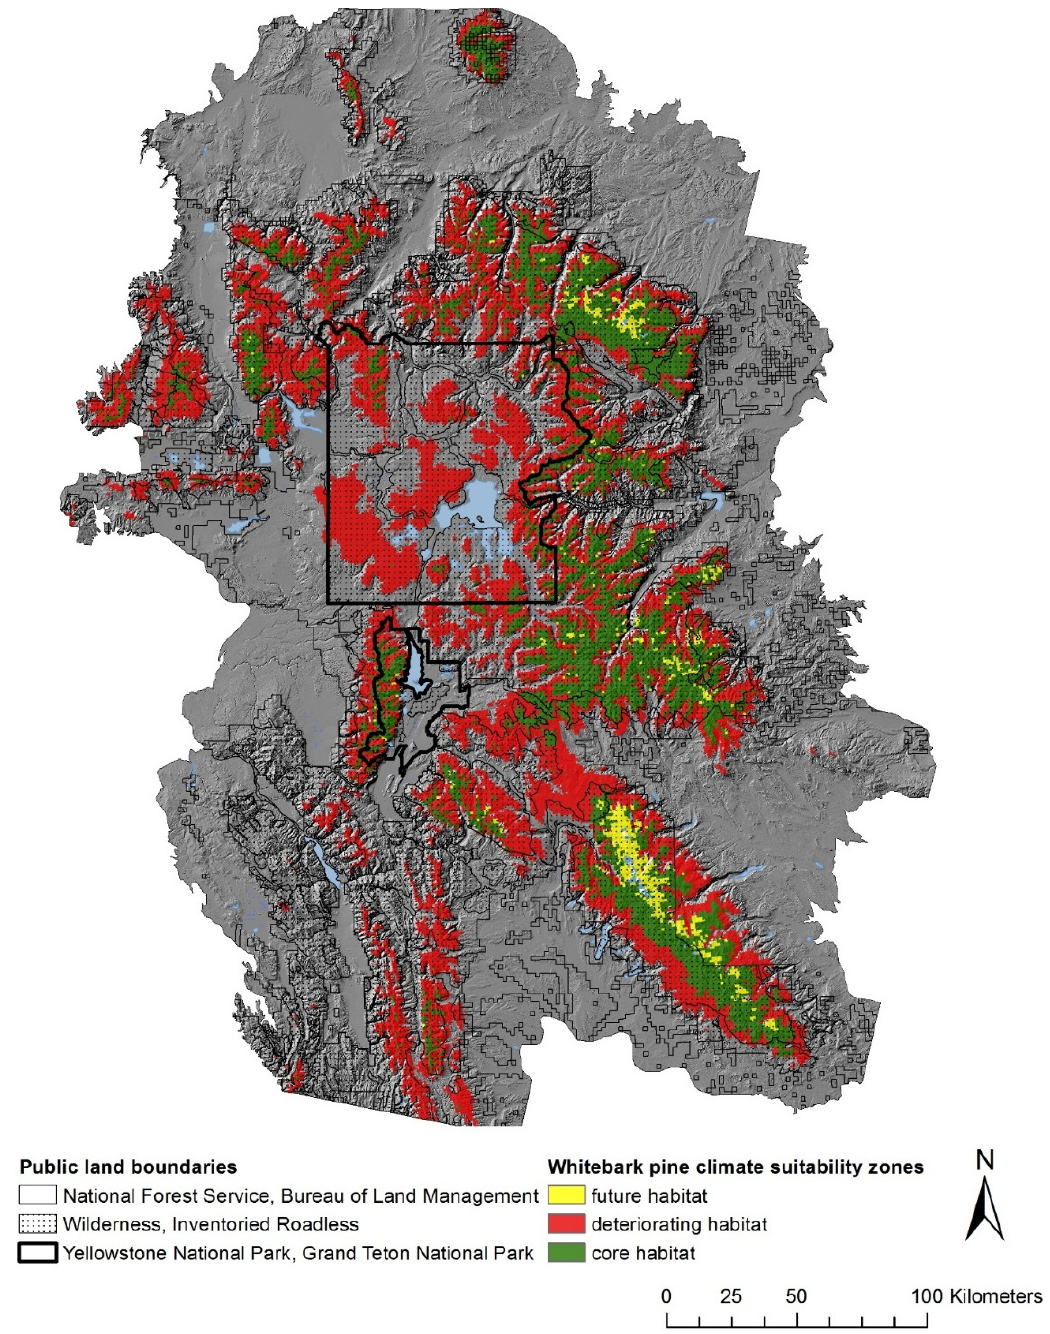
Figure 5. Distribution of projected deteriorating, core, and future habitat for WBP in the GYE under a moderate warming scenario for the period 2040–2070. These habitat projections are based on climate data from the CESM1-CAM5 global circulation model for the AR5 RCP 4.5 scenario [112]. WBP climate suitability is from [26]. Habitat types are defined in the text.